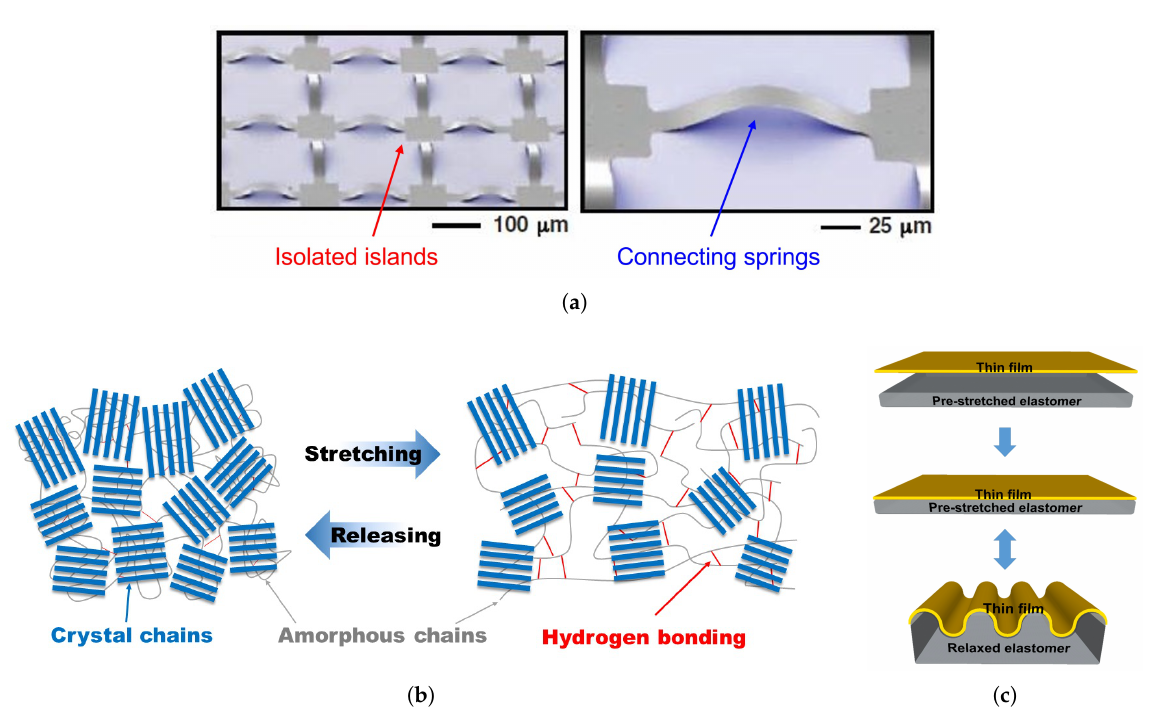
Figure 1. Three main approaches to physically flexible electronics; ( a ) rigid islands connected with micro-springs [5], ( b ) intrinsically stretchable materials, and ( c ) ultra-thin electronics laminated on soft and stretchable substrates. Reproduced with permission.